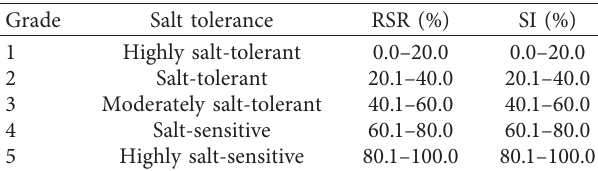
Table 2: Grading standard of salt tolerance at the germination stage and seedling